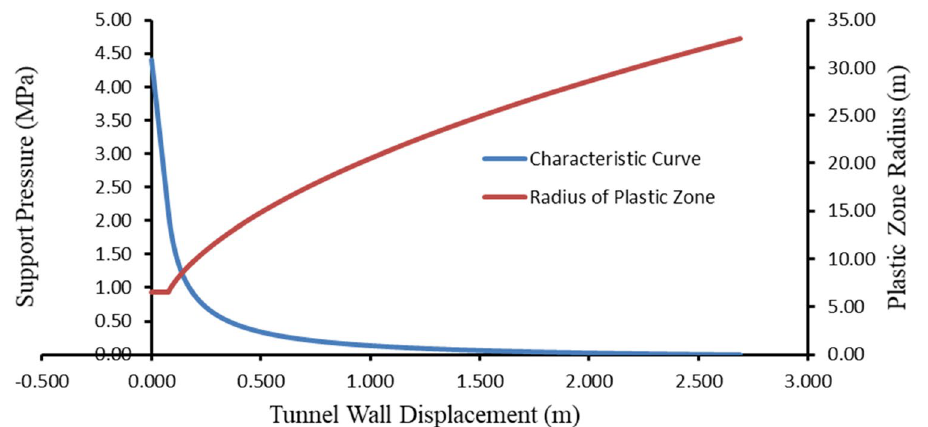
Figure 12. Longitudinal displacement profil for h = 200